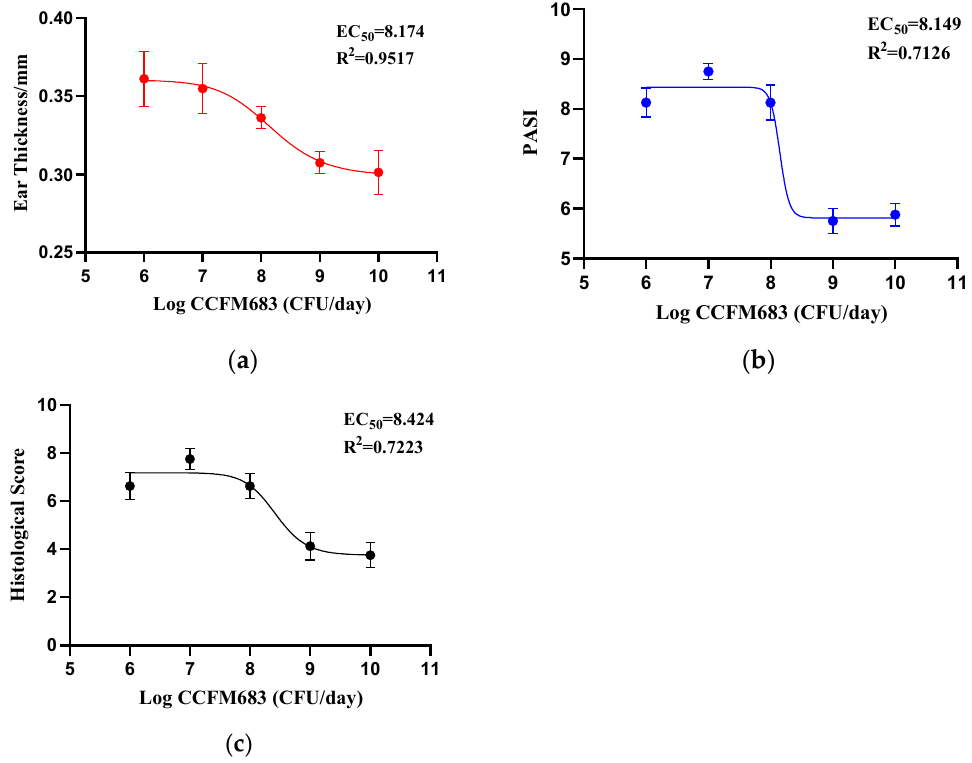
Figure 3. The dose–effect curve between CCFM683 dose and psoriasis indicators. ( a ) Ear thickness, ( b ) cumulative score, and ( c ) histological score of the skin. n = 8 mice per group. 3.4. The Effect of B. breve CCFM683 on Keratinocytes and Epidermal Barrier in Psoriasis Mice The mRNA level of the keratins (keratin 1, keratin 10, keratin 16, and keratin 17) and